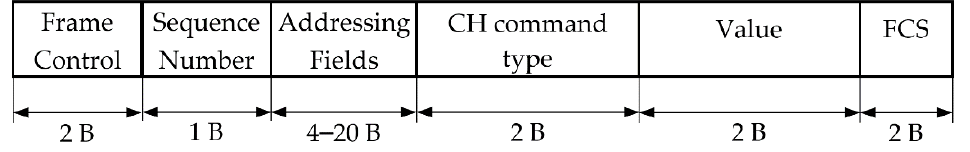
Figure 7. CH command frame format.